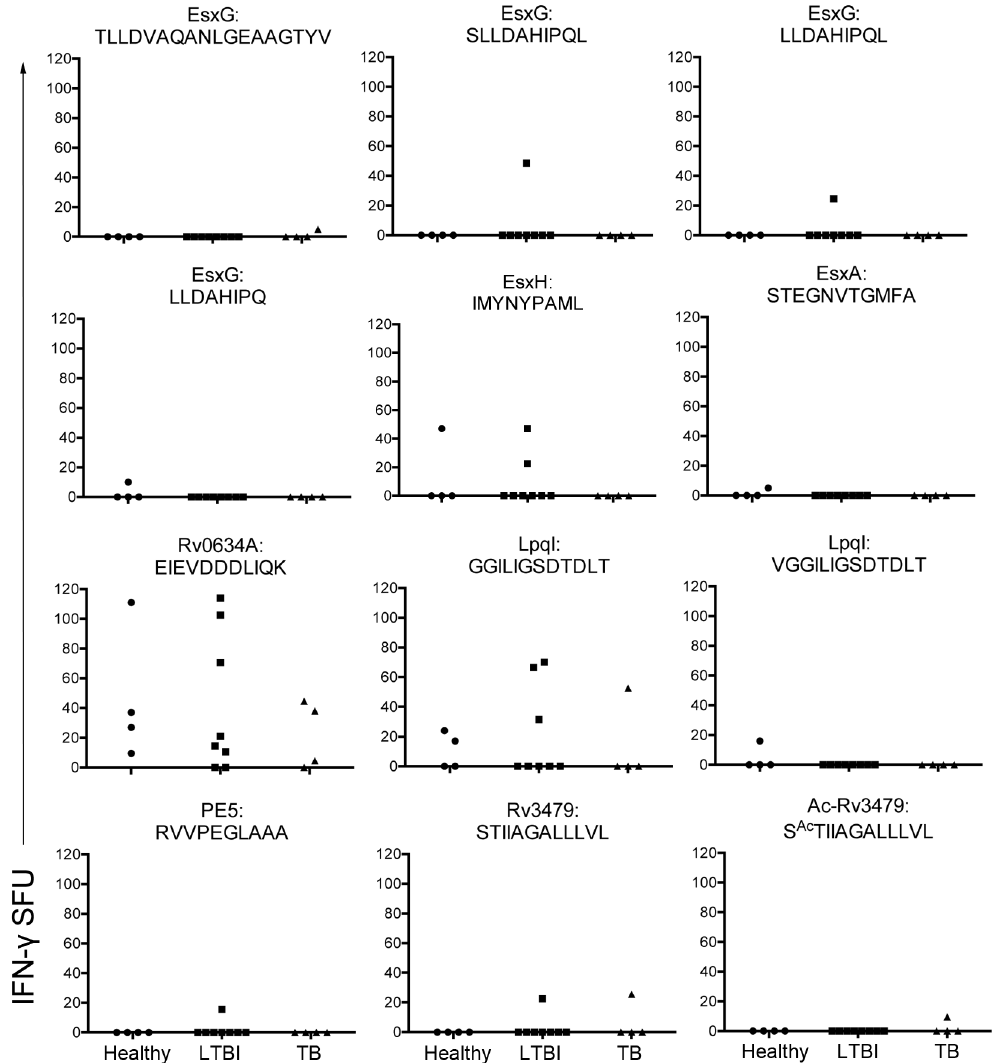
Fig 5. Mtb ligands are recognized by human Mtb-reactive CD8 + T cells. CD8 + T cells from four healthy, eight LTBI, and four Mtb-infecteddonors were incubatedin an IFN- γ ELISPOT plate with autologousDC pulsedwith each of the 28 validatedMtb peptides. Shownare the IFN- γ spot forming units for the 12 peptides for which at least one donor